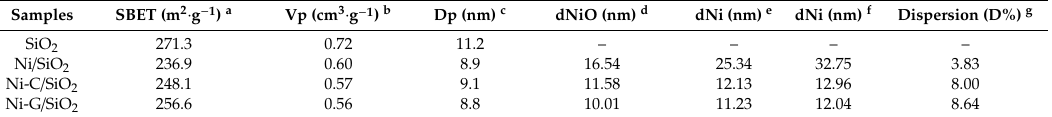
Figure 2. TEM images of the reduced catalysts.